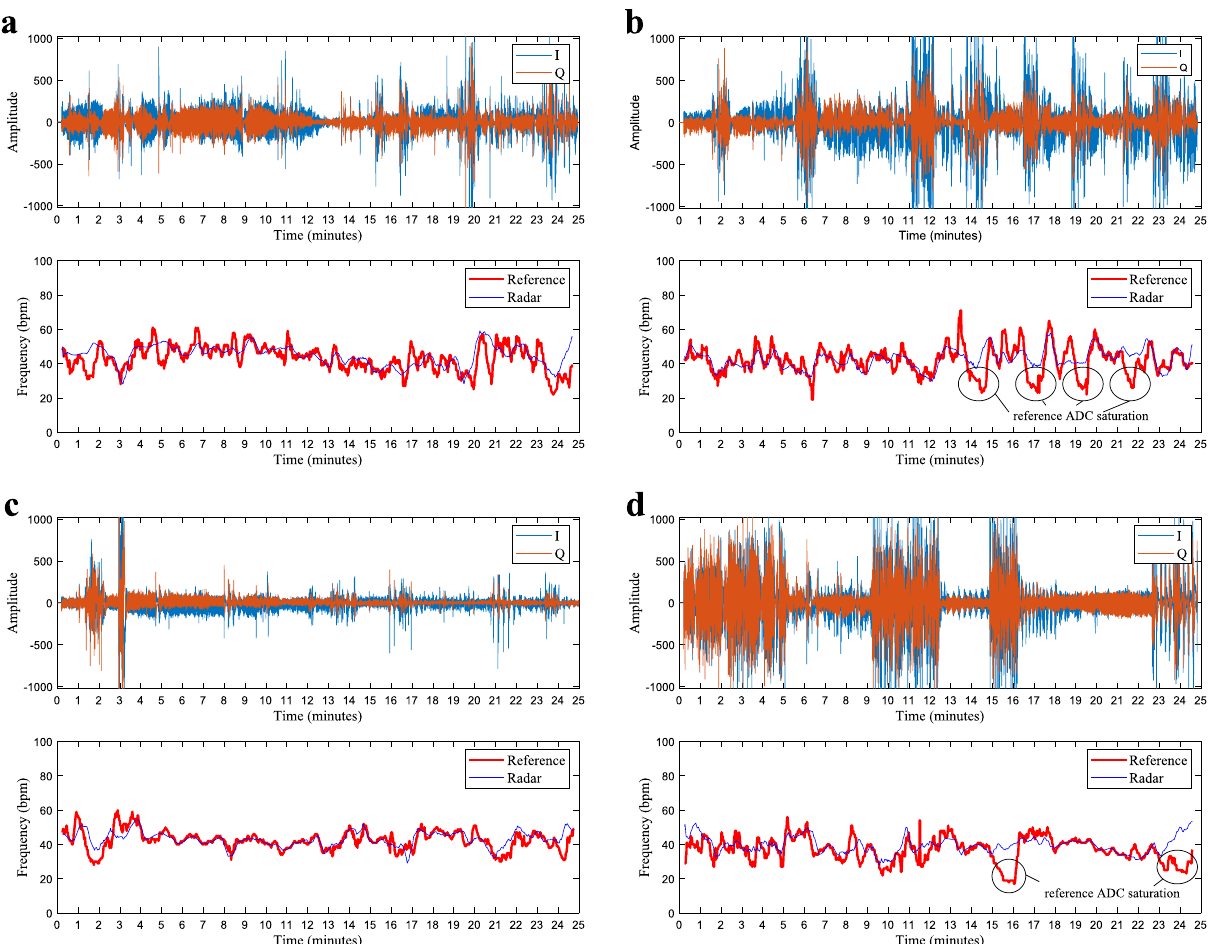
Figure 5. Radar input data and estimated breathing rate. All sequences were processed with the complete proposed solution (NLS+NMF), and each one represents a different monitoring scenario. ( a ) Single infant in supine position (chest facing the radar). ( b ) Single infant in prone position (back facing the radar). ( c ) Twins in the same bed, spaced by 20 cm, with the monitored infant in prone position. ( d ) Highly interfered